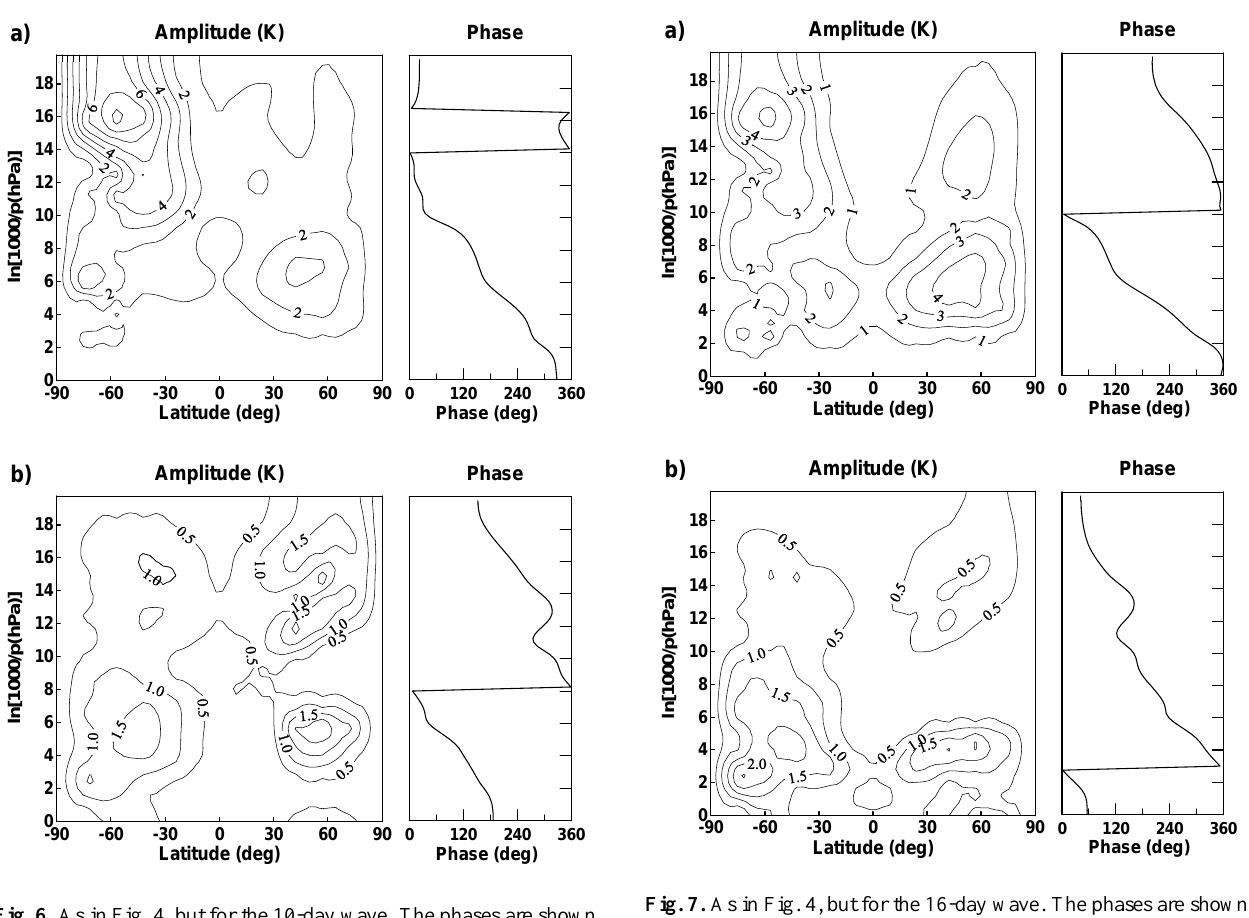
Fig. 6. As in Fig. 4, but for the 10-day wave. The phases are shown at 45 ◦ N ( a ) and 45 ◦ S ( b ) .